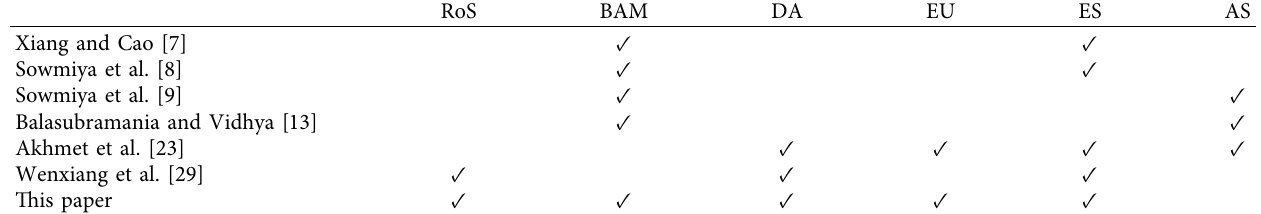
Table 1: Te brief comparison between this paper and existing literature.